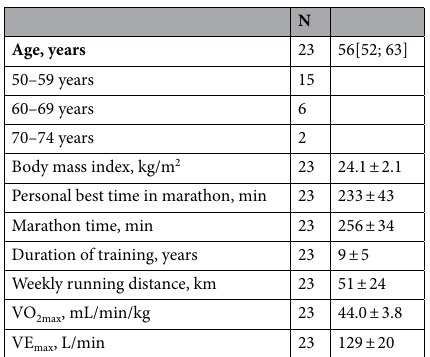
Table 1. Baseline characteristics of the examined men. Data are presented as mean ± SD or median with lower and upper quartile where appropriate; VO 2max , maximal oxygen consumption as assessed with cardiopulmonary exercise test; VE max , maximal minute ventilation during the cardiopulmonary exercise